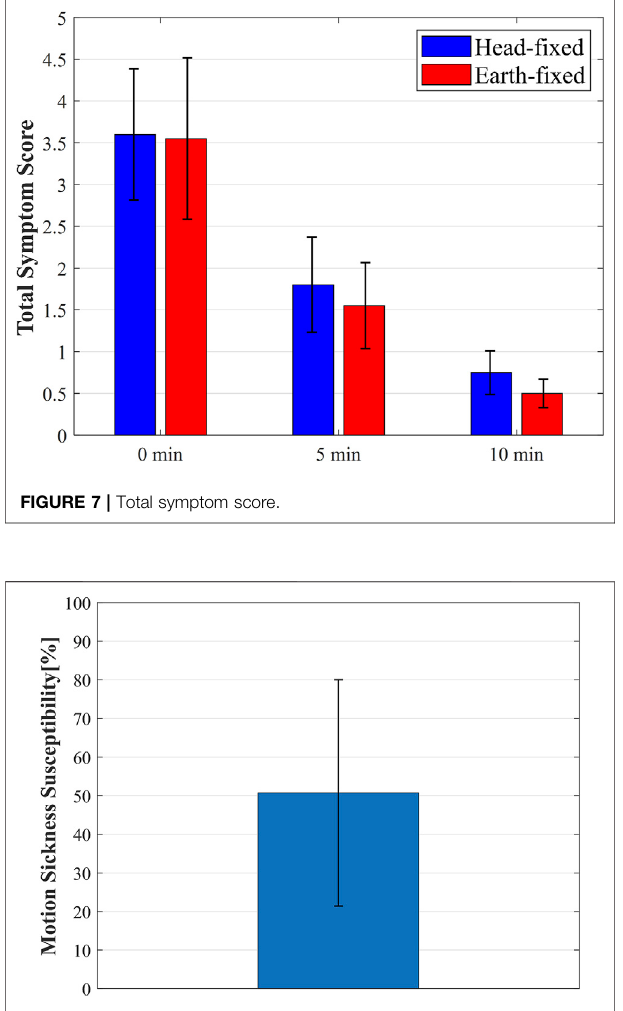
FIGURE 8 | Motion sickness susceptibility questionnaire.